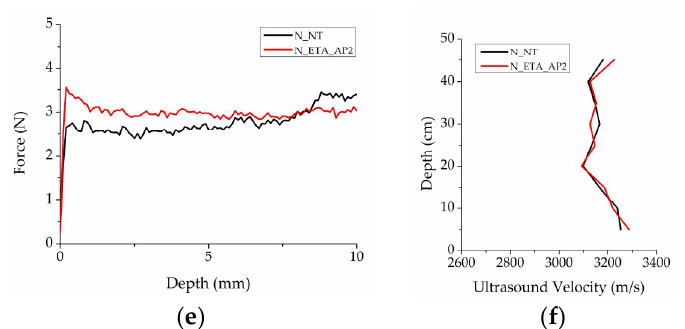
Figure 11. Noto stone treated through absorption by capillarity AP2: ( a ) drilling resistance of sample treated with NBU (N_NBU_AP2), ( b ) UPV profile of sample treated with NBU (N_NBU_AP2), ( c ) drilling resistance of sample treated with 2BU (N_2BU_AP2), ( d ) UPV profile of sample treated with 2BU (N_2BU_AP2), ( e ) drilling resistance of sample treated with ETA (N_ETA_AP2), ( f ) UPV profile of sample treated with ETA (N_ETA_AP2). NT: Untreated stone.